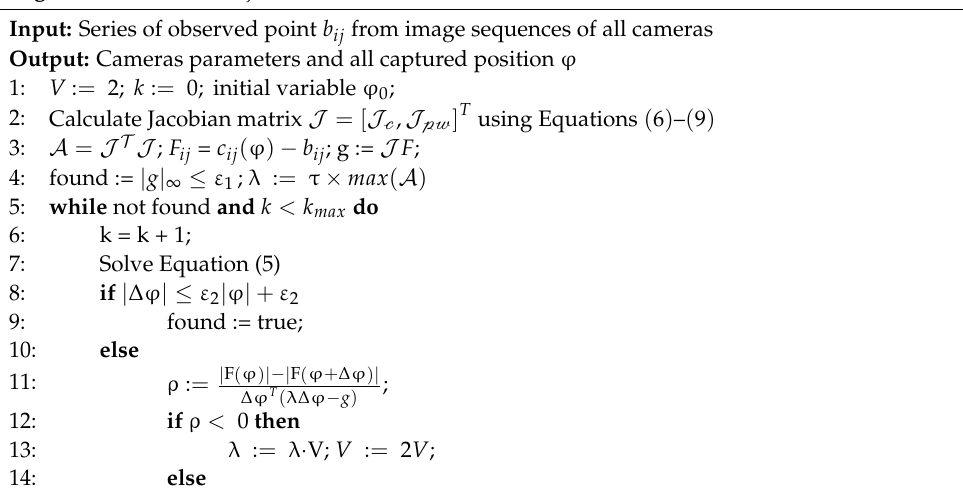
Algorithm 1: Bundle adjustment for motion estimation